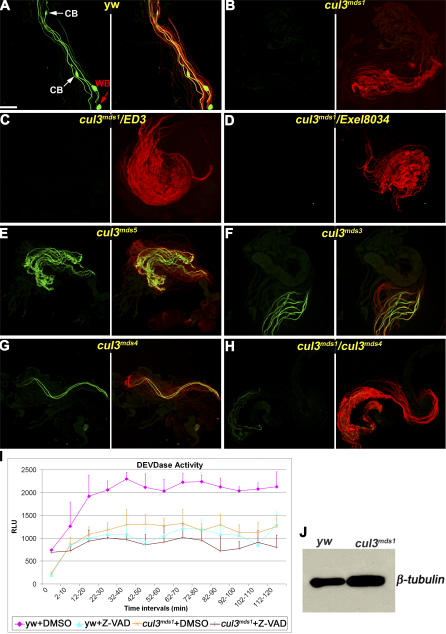
Mutations in cul3Testis Block Caspase Activation and Spermatid Individualization, but Not Axonemal Tubulin Polyglycylation(A–H) Visualization of active drICE with anti-cleaved caspase-3 antibody (CM1; green) and axonemal tubulin polyglycylation with anti-glycylated tubulin monoclonal antibody (AXO 49; red). These figures are composed of a green layer only in the left panel, and green and red layers combined in the right panel.(A) Wild-type individualizing spermatids stain positively for active effector caspase and polyglycylated axonemal tubulin (white arrows pointing at cystic bulges [CBs] and red arrow pointing at a waste bag [WB]).Elongated spermatids from (B) homozygotes for the null cul3mds1 allele or (C and D) transheterozygotes for cul3mds1 and two different deficiencies that cover the cullin-3 gene, DF(2L)ED3 and DF(2L)Exel8034, respectively, stain for polyglycylation but not for active effector caspase.(E–G) Homozygote mutants for three hypomorphic cul3Testis alleles, cul3mds5, cul3mds3, and cul3mds4, respectively, have spermatid individualization defects but still display some levels of active effector caspase expression.(H) However, the level of active effector caspase expression was dramatically reduced in spermatids from transheterozygote mutants for the null cul3mds1 and either of the hypomorphic alleles, such as cul3mds4.All the figures are in the same magnification; scale bar 200 μm.(I) The diagram depicts a DEVDase activity assay for cul3mds1
−/− testes. Caspase-3–like (DEVDase) activity is detected in wild-type testes and is blocked either after treatment with the caspase-3 inhibitor Z-VAD.fmk or in cul3mds1
−/− testes. DEVDase activity, presented as relative luminescence units (RLUs), was determined on Ac-DEVD-pNA substrate in testis extracts made of 180 wild-type (yw) or cul3mds1
−/− testes treated with Z-VAD or left untreated (DMSO). Readings were obtained every 2 min, and each time interval represents an average (mean ± SEM) of five readings. Note that the level of DEVDase activity in cul3mds1
−/− testes is highly similar to the corresponding level in wild-type testes that were treated with Z-VAD.(J) A Western blot analysis for the assessment of the relative protein amounts used in (I). A portion of the testis extracts in (I) were used as controls to determine the relative amounts of total protein in each extract using the anti-β-Tubulin antibody.